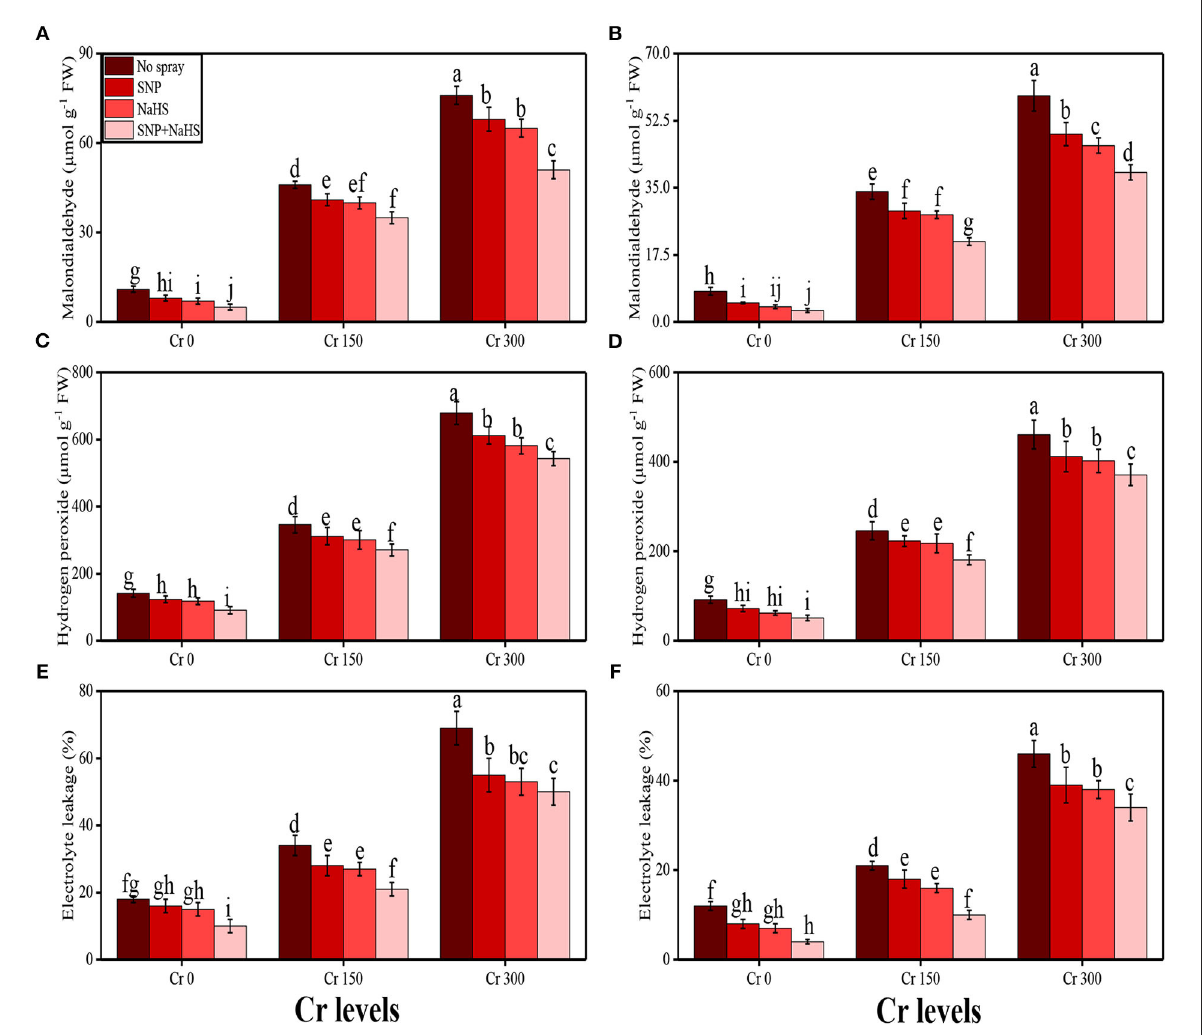
FIGURE3 Impact of individual and combinatorial application of SNP and NaHS on oxidative stress indicators, i.e., MDA content in the roots (A) , MDA content in the leaves (B) , H 2 O 2 content in the roots (C) , H 2 O 2 content in the leaves (D) , EL percentage in the roots (E) , and EL percentage in the leaves (F) of spinach ( S. oleracea ) plants grown under different levels of Cr [0 (no Cr), 150, and 300 µ M] in sandy loam soil. Values in the figures indicate just one harvest. Mean ± SD ( n = 4). Two-way ANOVA was performed and mean differences were tested by HSD ( P < 0.05). Different lowercase letters on the error bars indicate significant differences between the